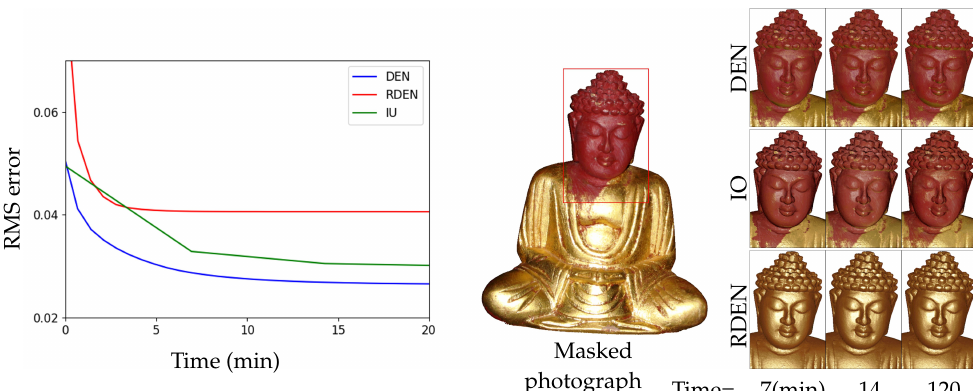
Figure 4. ( left ) RMS errors between reconstructions and photographs according to the computation time. ( right ) DEN: DEN with initialization of B ∗ , RDEN: Randomly-initialized DEN by glorot uniform distribution, IO: Iterative Optimization. The middle figure is a masked photograph. The highlighted figures are the reconstruction result of each method at t = 7, 14, and 120